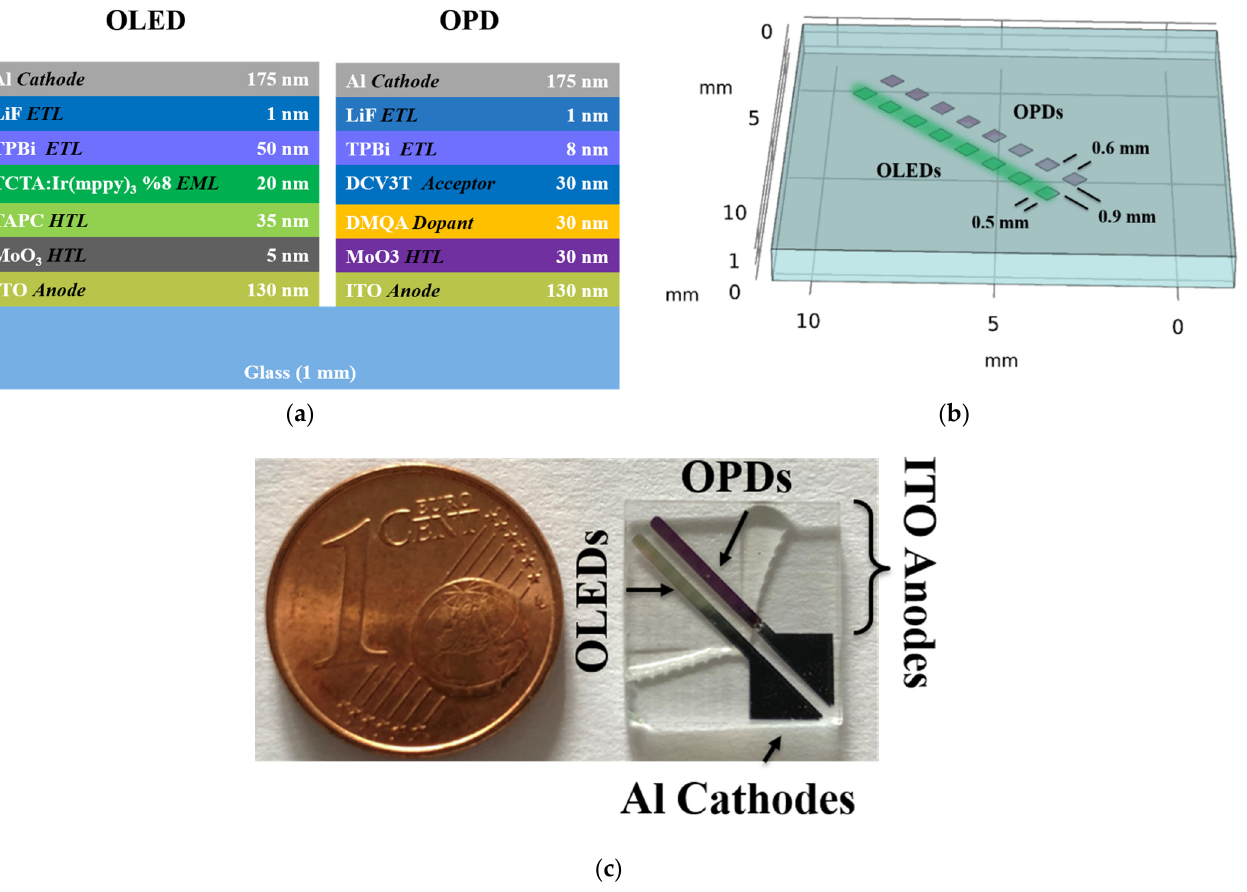
Figure 1. ( a ) Schematic diagram of the OLED and OPD stacks on a single glass substrate; ( b ) geo- metrical model of the OLED–OPD unit layout with 8 units on one test chip; ( c ) photograph of a fabricated test chip.